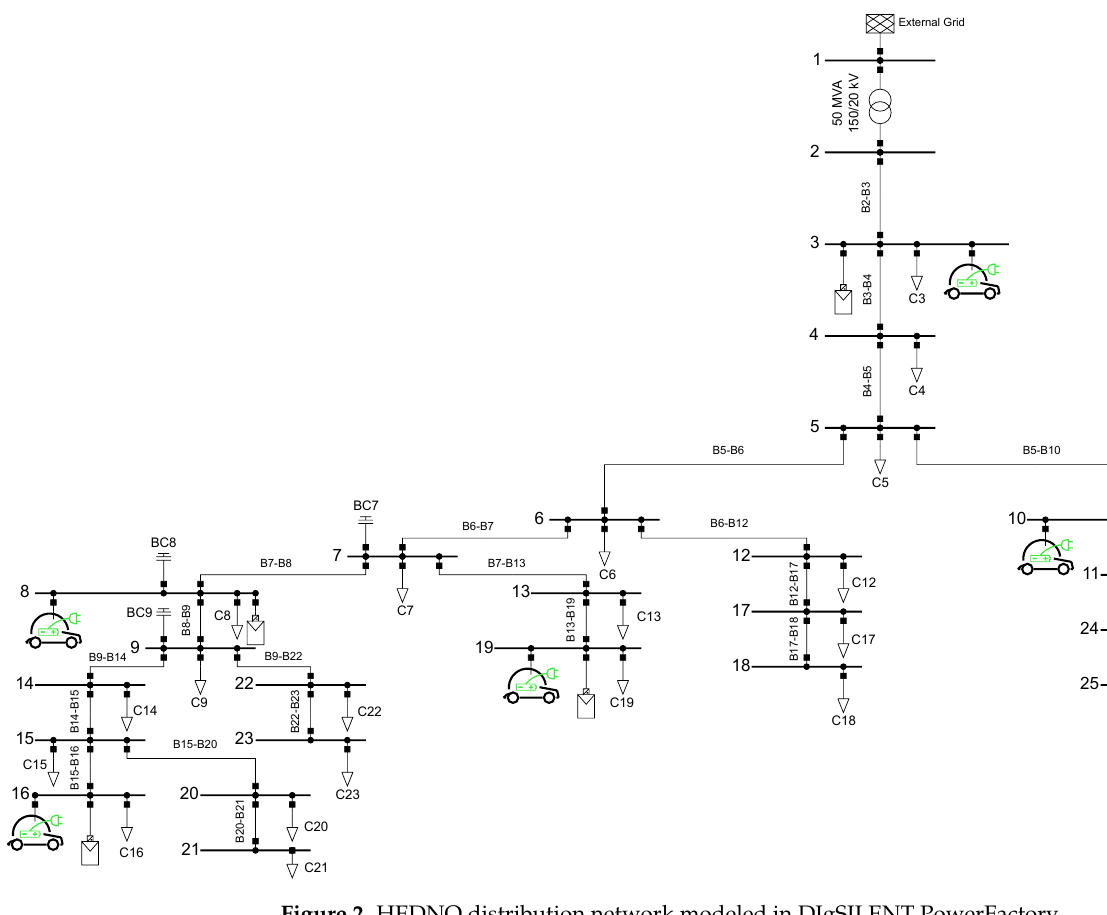
Figure 2. HEDNO distribution network modeled in DIgSILENT